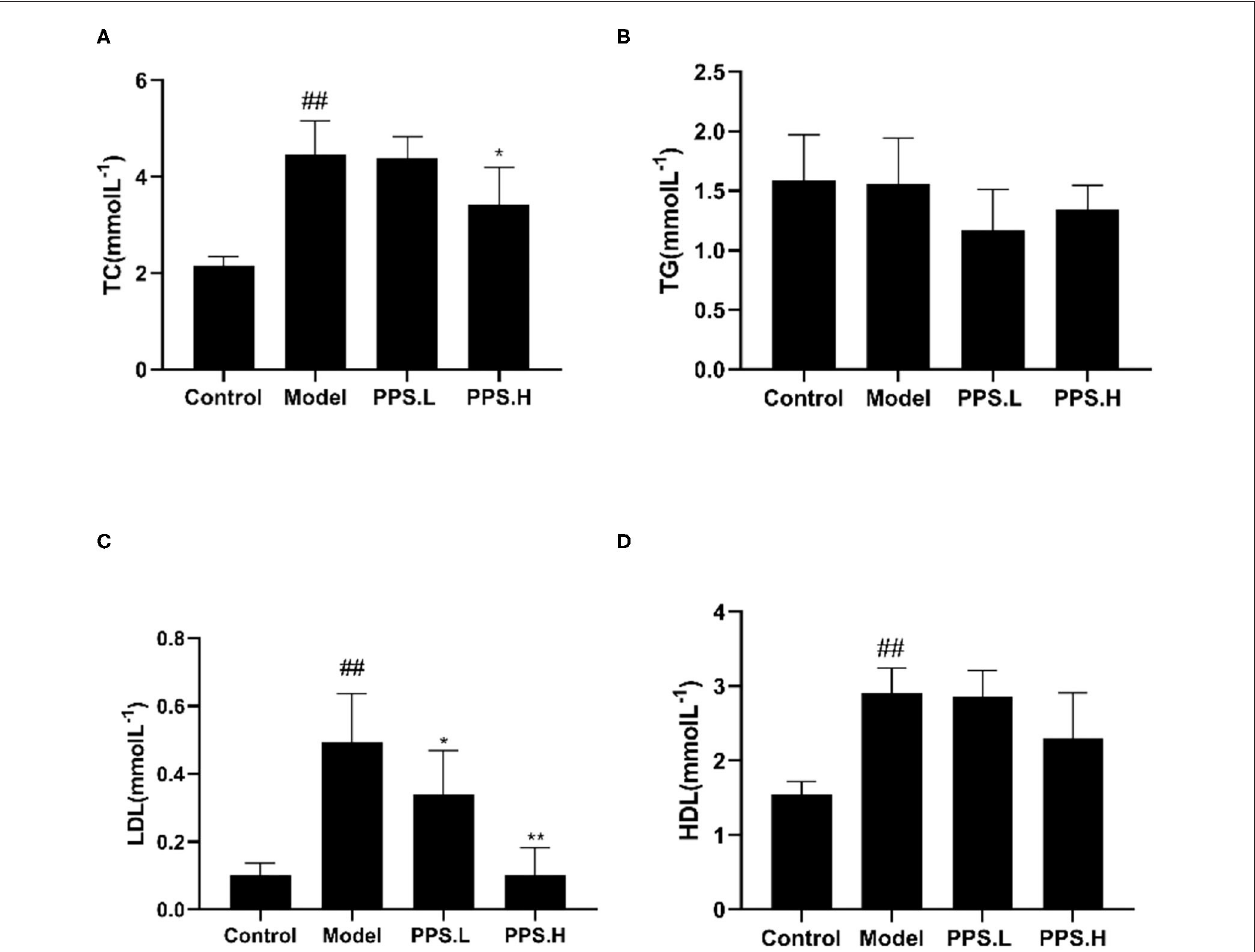
FIGURE 8 | Effect of crude pumpkin polysaccharide on the plasma lipids in mice. (A) Total cholesterol (TC). (B) Triglycerides (TG). (C) Low-density lipoprotein (LDL). (D) High density lipoprotein (HDL). Eight mice in each group. Values are expressed as mean ± SD. ## p < 0.01, # p < 0.05 vs. control group; ** p < 0.01, * p < 0.05 vs. model group. PPS.L, pumpkin crude polysaccharide low-dose group (diabetic rats, gavage with W-CCPs at 600 mg/kg b.w.); PPS.H, pumpkin crude polysaccharide high-dose group (diabetic rats, gavage with W-CCPs at 1,200 mg/kg